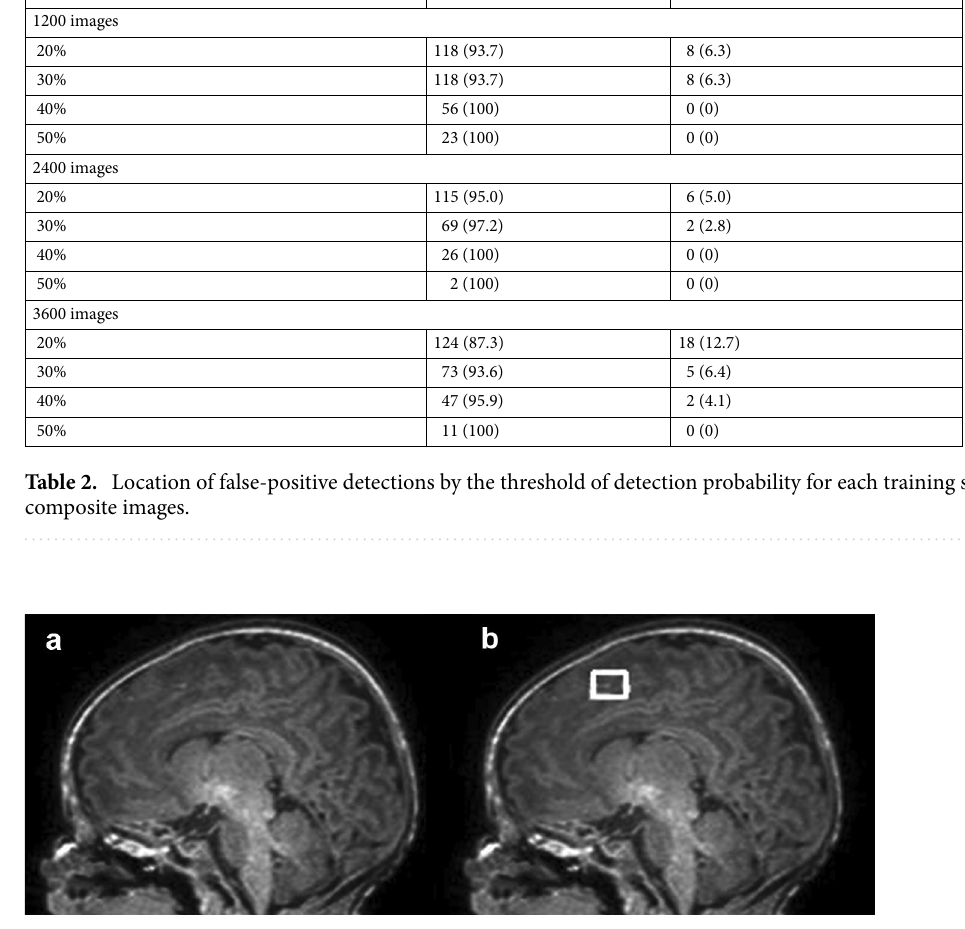
Figure 3. False-positive detection of punctate white matter lesions (PWMLs) in an infant. Automatic detection in ( b ) (square) appears to be a PWML but actually was a part of the cerebral cortex ( a